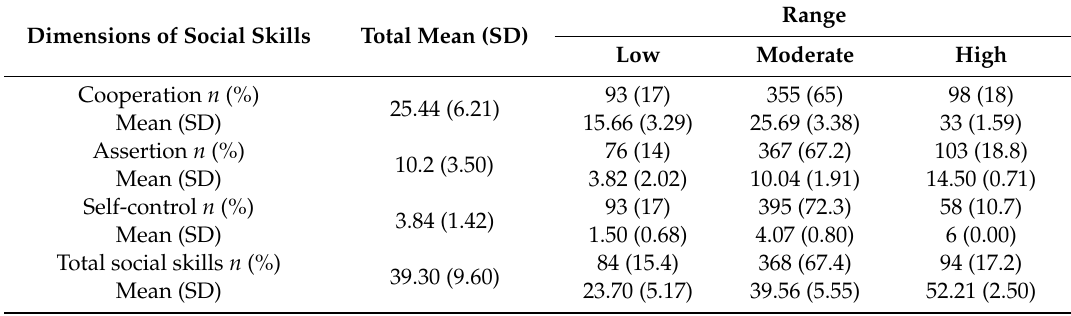
Table 2. Social skills in the preschool age children from the teachers’